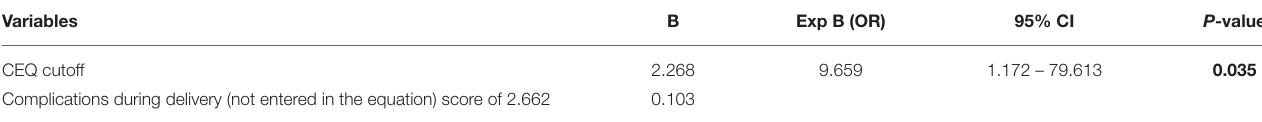
TABLE 2 | Logistic regression – multivariate analysis. Variables B Exp B (OR) 95% CI P -value CEQ cutoff Complications during delivery (not entered in the equation) score of 2.662 0.103 The values in bold mean statistical